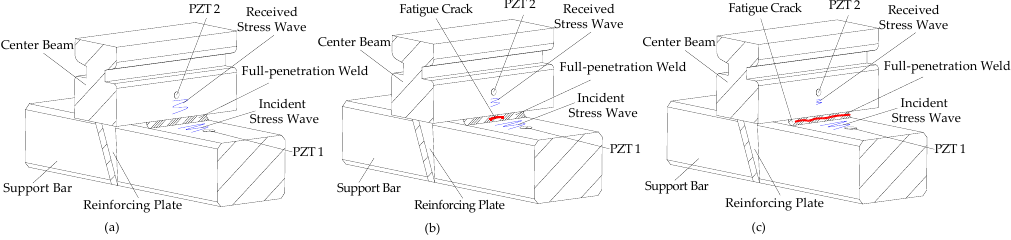
Figure 2. The principle of the active-sensing approach. ( a ) The initial state before fatigue loading. ( b ) Fatigue crack occurs in the weld throat. ( c ) Fatigue crack grows along the longitudinal axis of the center beam.